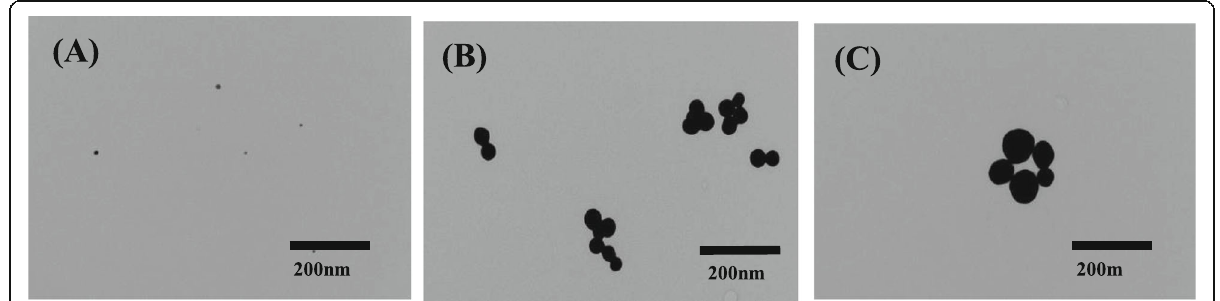
Fig. 1 Ultrastructures of gold nanoparticles. Electron micrographs of GnP10 ( a ), GnP50 ( b ), and GnP100 ( c )